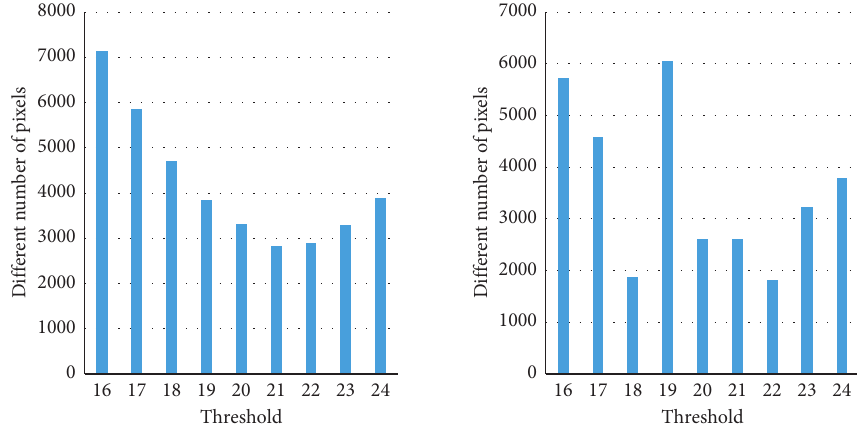
Figure 7: Moving target image reference image